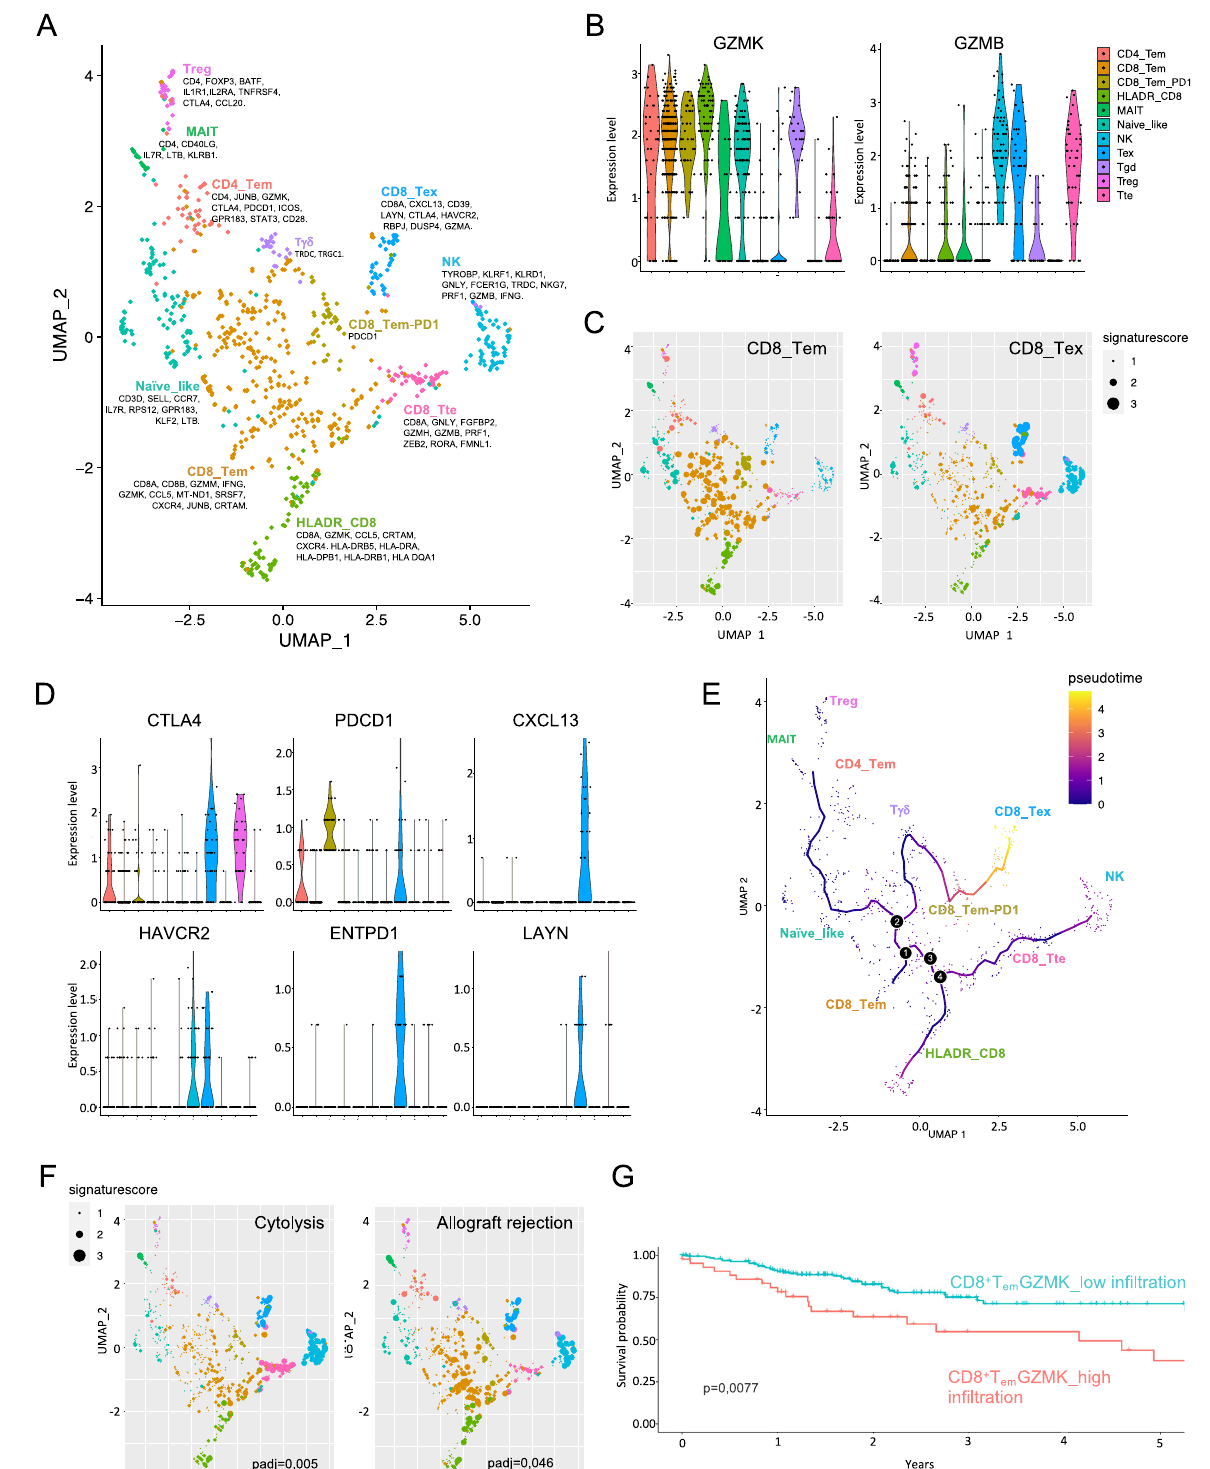
Fig. 4 | Single-cell RNAseq analysis on CRC patients de fi nes an effective prog- nosticsignaturebasedonCD8_T em in fi ltration.A – F scRNAseqanalysison8CRC patients. A UMAP projection of CD8 + T cells. Colors represent different T cell subtypes. Key genes used for manual annotation are indicated. B Violin plots showing normalized expression of GZMB and GZMK in the different T CD8 + cell subtypes. C UMAPshowingtheexpressionofCD8_TemandCD8_Texsignaturesfor each cell. Cells are color coded based on SNN-clustering, dot ’ s size re fl ects the expression of the signature for each cell. D Violin plots showing the expression of